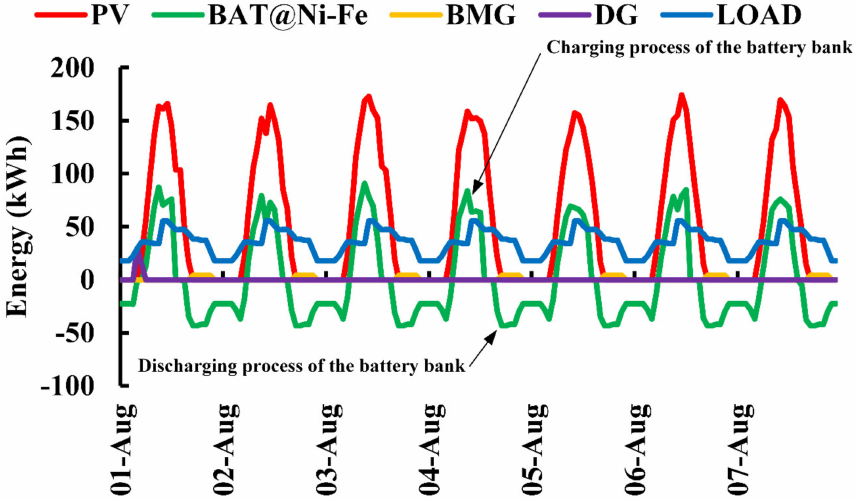
Figure 16. During one week of the summer season in August, energy outputs of various components of the Ni-Fe battery-based IHRES with LF strategy using LPRAHC